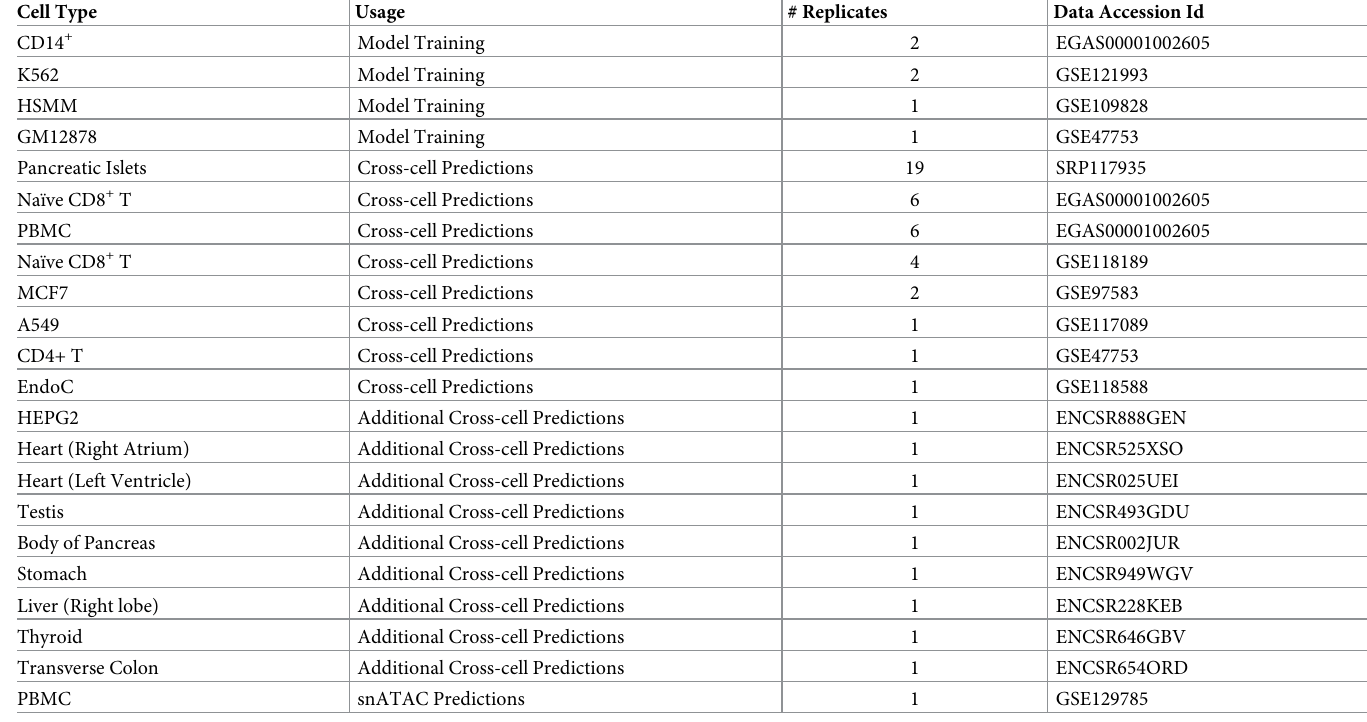
Table 1. ATAC-seq samples used in model training and